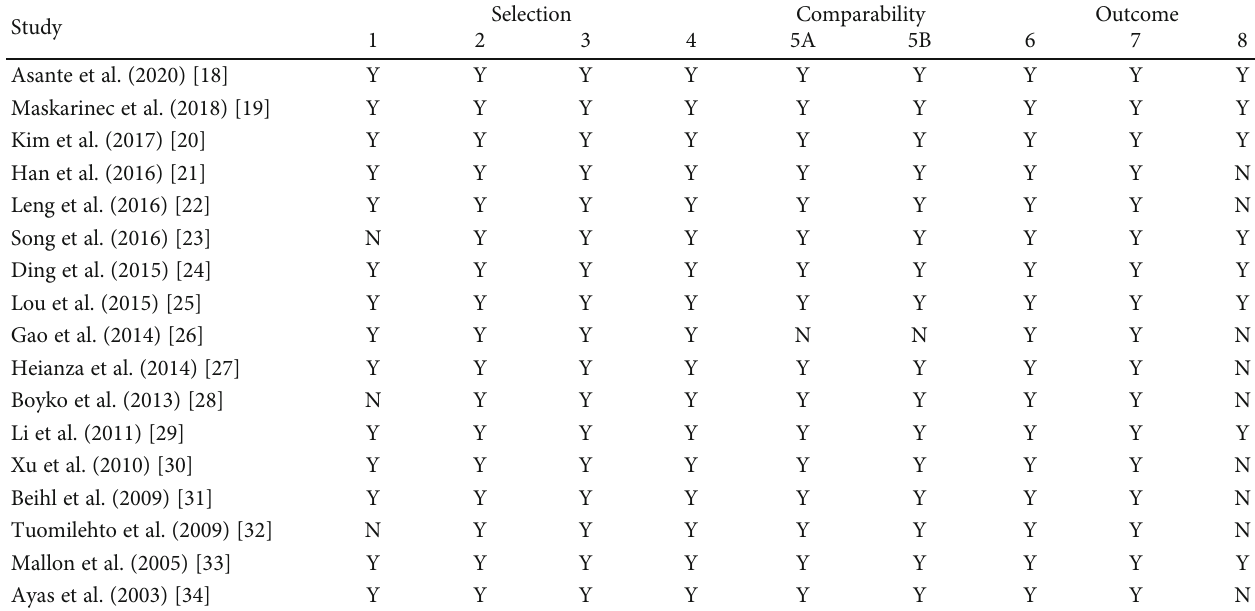
Table 2: Quality of included studies.